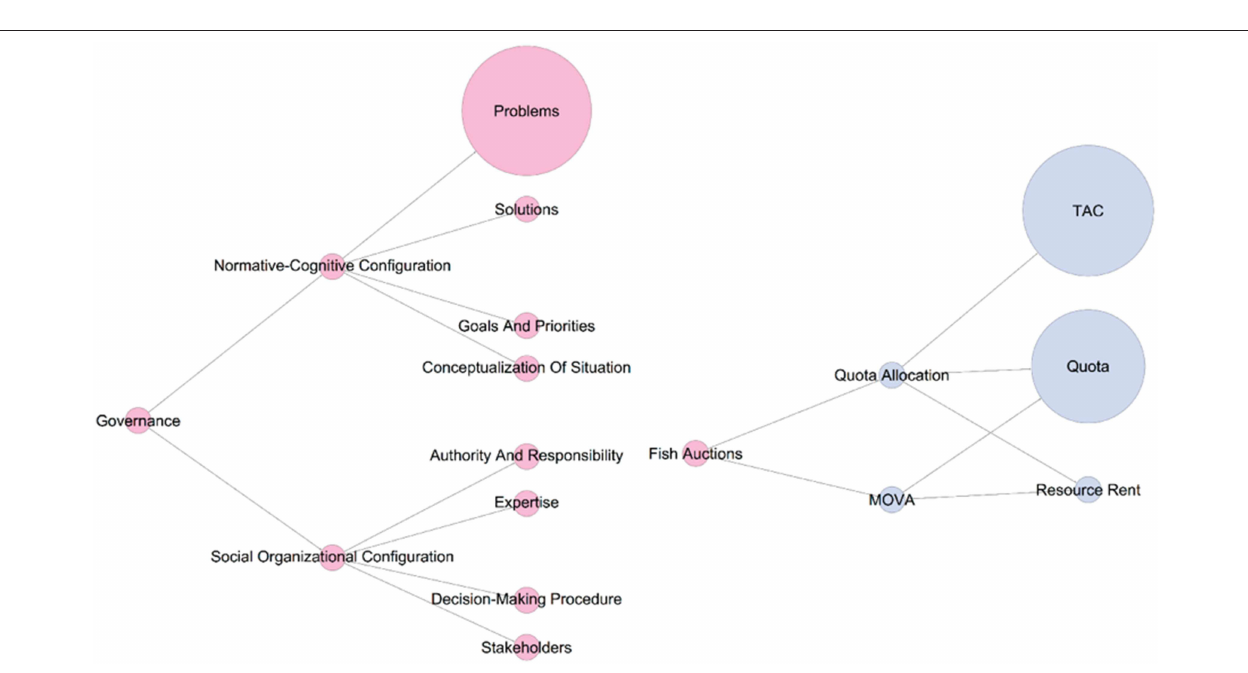
from three different dimensions ( n = 12) and five HDAs were modeled using Level 2 and Level 3 variables